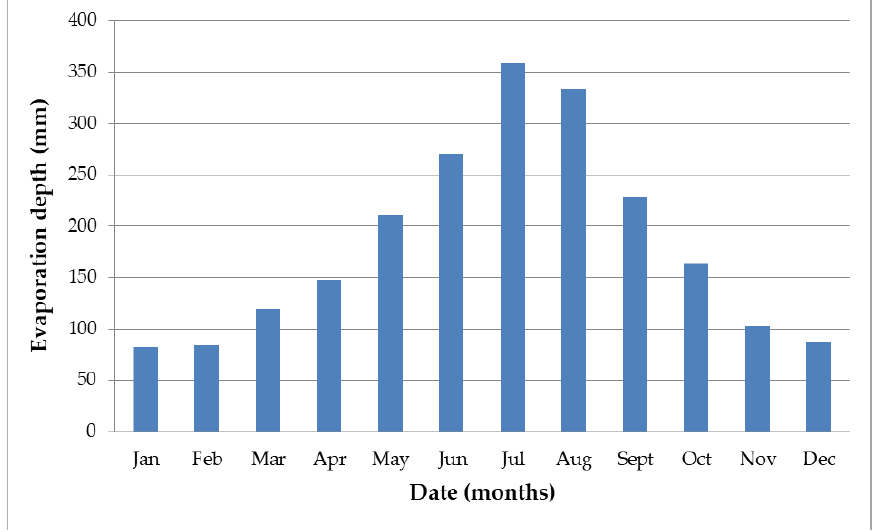
Figure 5. Mean monthly evaporation data.